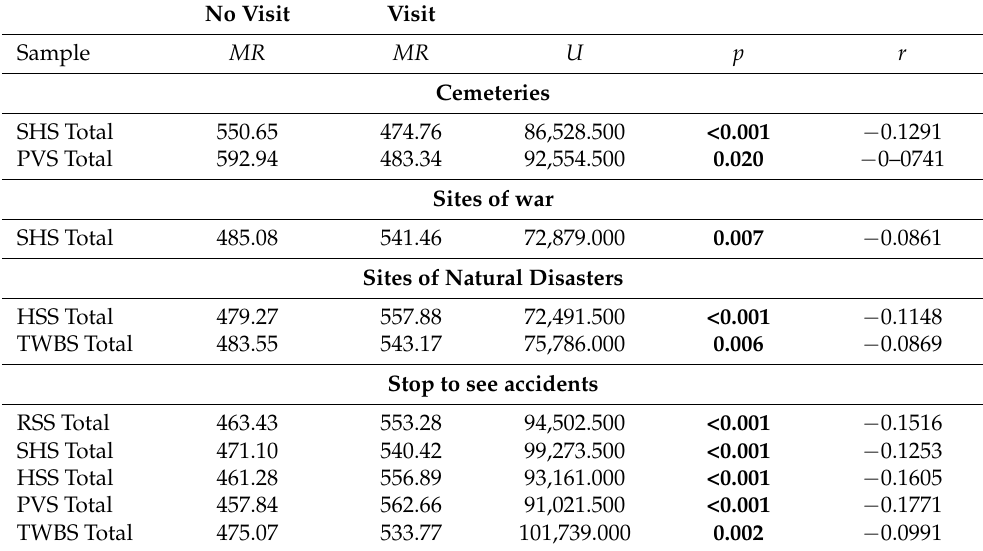
Table 6. Rumination on sadness (RSS), self-hatred (SHS), hostility (HSS), psychological vulnerability (PVS) and tourism wellbeing (TWBS) frequencies and differences according to dark tourism practices. No Visit Visit Sample MR MR U p r Cemeteries SHS Total 550.65 474.76 86,528.500 <0.001 − 0.1291 PVS Total 592.94 483.34 92,554.500 0.020 − 0–0741 Sites of war SHS Total 485.08 541.46 72,879.000 0.007 − 0.0861 Sites of Natural Disasters HSS Total 479.27 557.88 72,491.500 <0.001 − 0.1148 TWBS Total 483.55 543.17 75,786.000 0.006 − 0.0869 Stop to see accidents RSS Total 463.43 553.28 94,502.500 <0.001 − 0.1516 SHS Total 471.10 540.42 93,161.000 <0.001 − 0.1605 457.84 562.66 <0.001 − 0.1771 TWBS Total 475.07 533.77 101,739.000 0.002 −